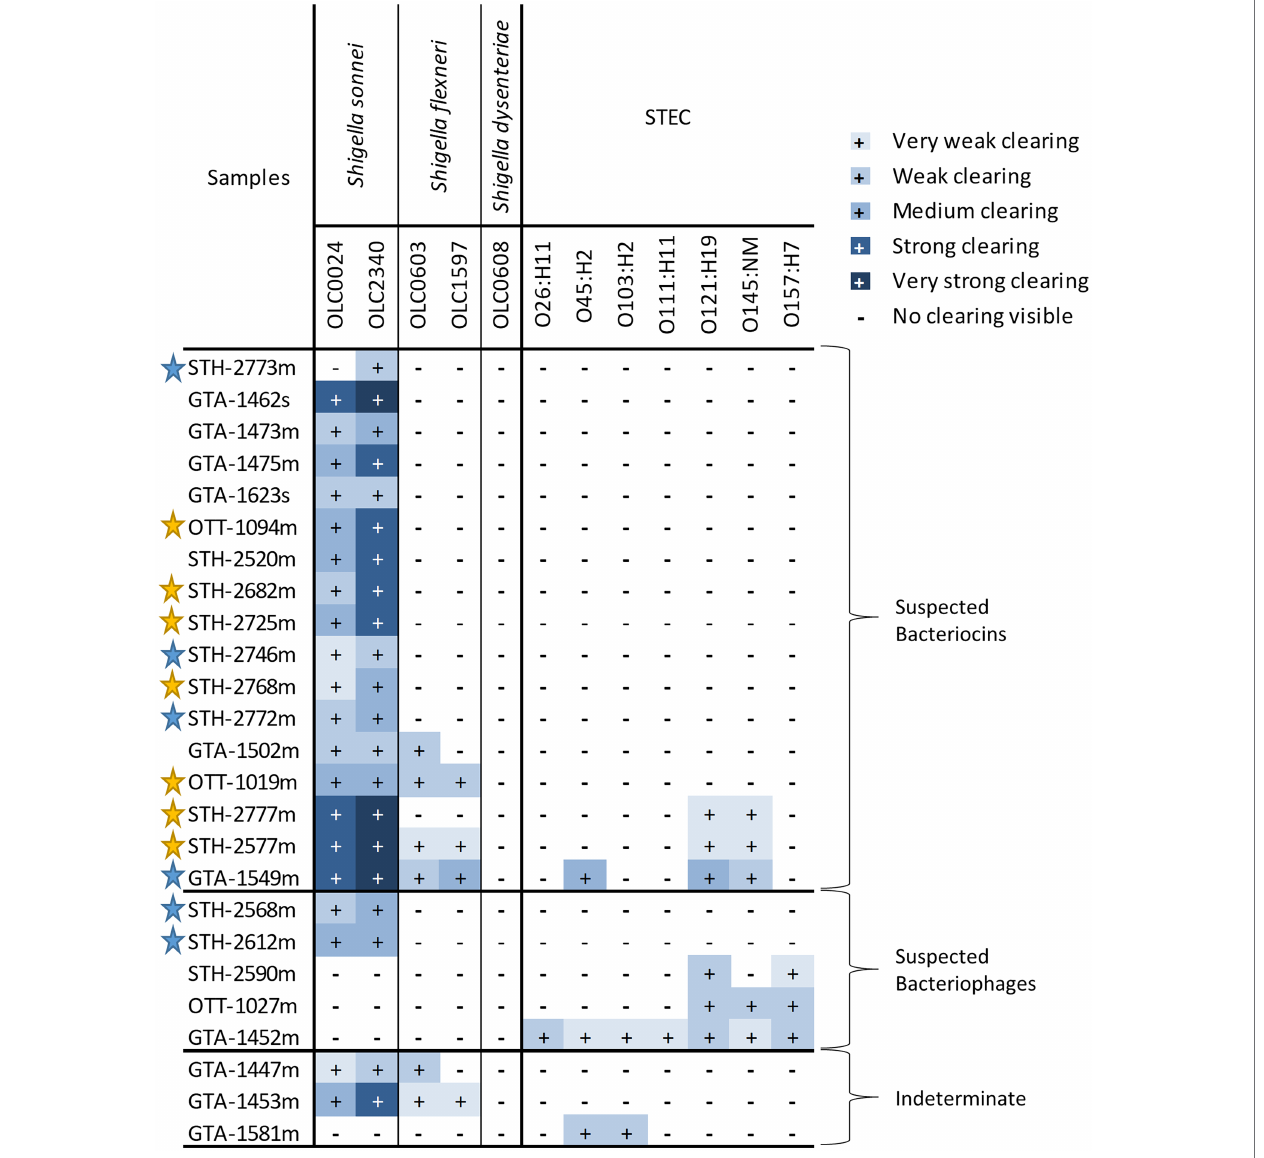
FIGURE 5 | Strengths of inhibitory activity of food enrichments on Shigella and STEC. Relative strength of inhibitory activity of extracts from mTSB (“m” in sample name) and SB enrichment (“s” in sample name) on Shigella spp. and STEC is indicated (see Figure 3A for representative images of different strengths of inhibitory activity). The enrichments are grouped based on predicted inhibitor present in the sample (bacteriocins, bacteriophage, or both). Samples were deemed to be indeterminate if observed inhibition of untreated samples was weak and impacts of proteolytic enzymes and dilutions could not be observed. Stars indicate samples for which attempts were made to recover isolates of the bacteria responsible for inhibition. Yellow stars indicate that an isolate producing an inhibitor was recovered, blue stars indicate attempts to recover isolates from samples were